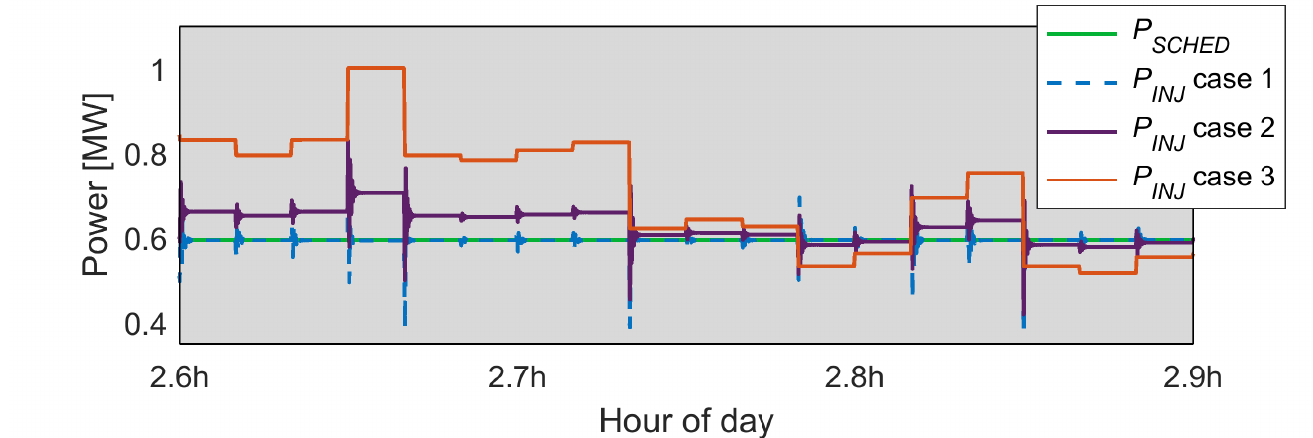
Figure 25. Scenario 1: Zoom in the njected power and tolerated band/injection region.